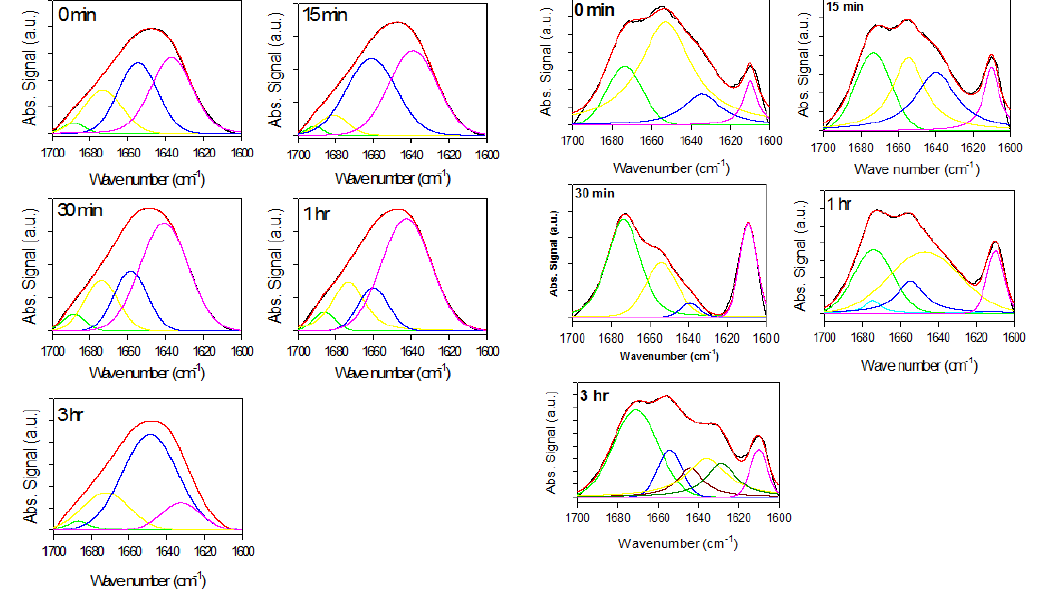
Figure 2. Attenuated total reflectance Fourier transform infrared spectroscopy (ATR- FTIR) spectra of supernatant samples (left panels) and precipitate samples (right panels) taken at time of rotenone addition. Black curves are experimental signals; red curves are fits. Signals under curve represent deconvoluted experimental curve-fit signals bands used to determine structural content in a given sample and positioned at ~1635 cm −1 (pink lines),